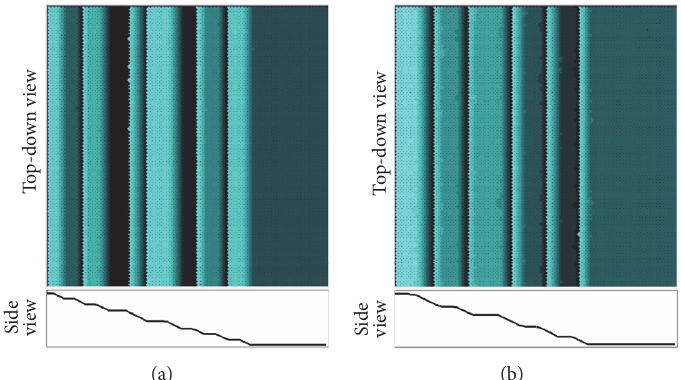
Figure 9: Freezing of the surface structure in the step-faceting zone. (a) 𝑘 𝐵 𝑇/𝜖 = 0.2 . (b) 𝑘 𝐵 𝑇/𝜖 = 0.4 . 𝜖 int /𝜖 = −0.9 . 𝑁 step = 60 . Size: 80√2 × 80√2 . Time: 2 × 10 8